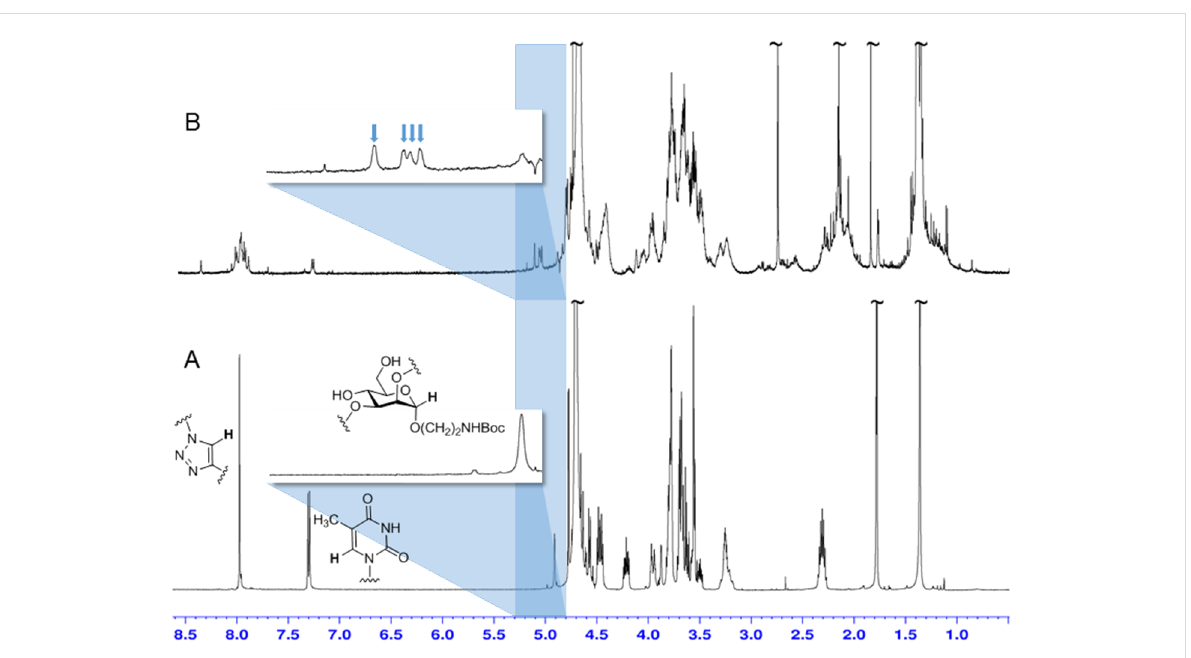
Figure 3: 1 H NMR spectra (all in D 2 O, 500 MHz) of mannoside 13 (A) and of the irradiation product ( 14 ) after 6 hours irradiation time (B). Photocy- cloaddition is indicated by the changes of the signals for the triazole H-11 and the thymine H-6 protons (left at low field) and the anomeric H-1 of the carbohydrate scaffold ( ≈ 4.9 ppm). The anomeric H-1 region is detailed in both cases: four new signals are seen in 14 (B) (blue arrows) corresponding to four different isomeric products of the